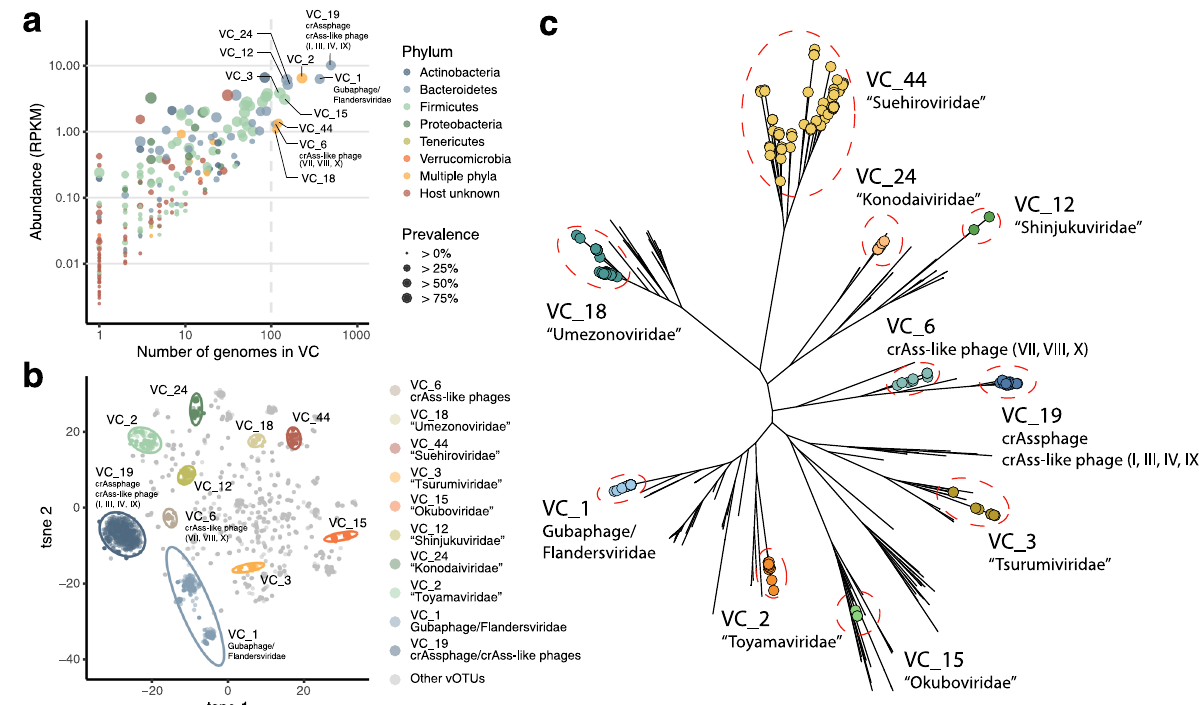
Fig. 2 | Identi fi cation of novel viral clusters abundant and prevalent in the human gut. a Average abundance of each VC among the 4198 individuals and the number of genomes forming the VC. The colour and size of each circle represent the phylum-level taxonomy of the predicted host and prevalence of the VC in the cohort, respectively. b Similarity of phage genomic content (proportion of shared proteins) visualised by tSNE. The colour of each circlerepresents the VC